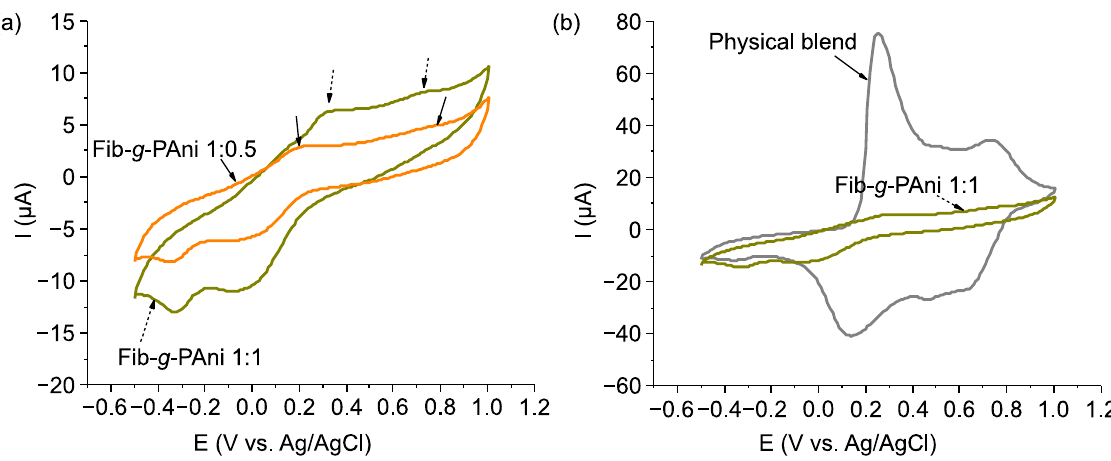
Figure 7. Voltamogramms of ( a ) Fib- g -PAni copolymers and ( b ) comparison between physical blends and graft copolymers.